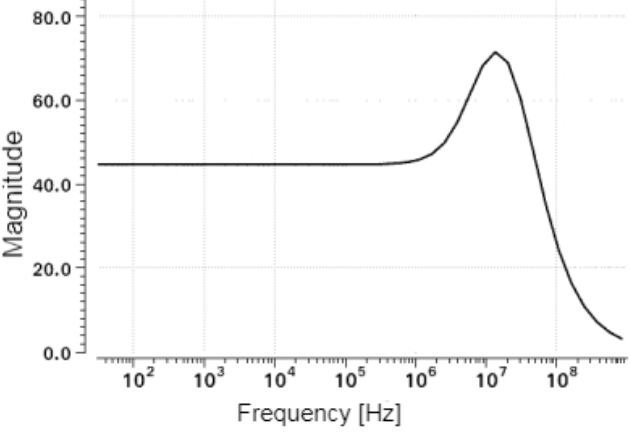
Figure 4. Input impedance of charge-sensitive preamplifier.